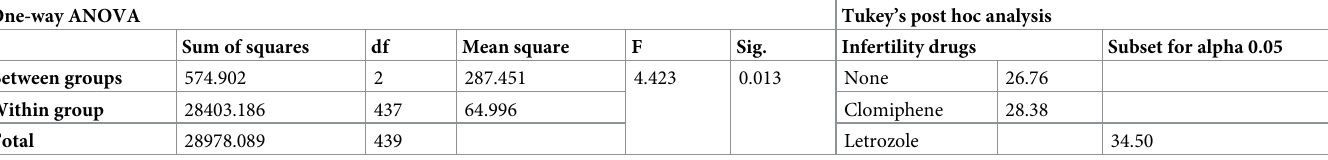
Table 7. One-way ANOVA and post hoc analysis of differences in terms of QOL scores between patients receiving clomiphene and those receiving letrozole. One-way ANOVA